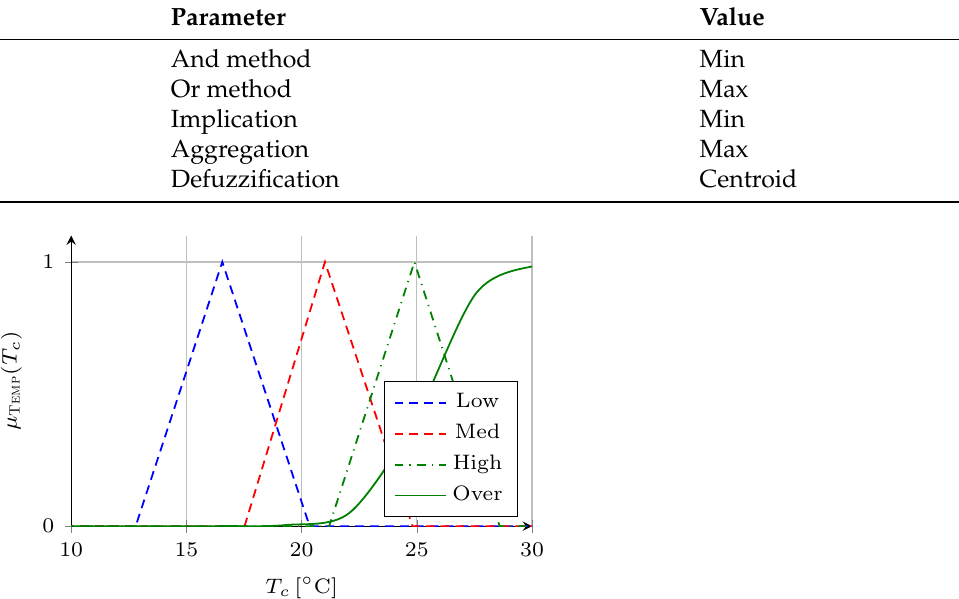
Figure 2. Membership functions for the input fuzzy sets corresponding to the linguistic variable T EMP